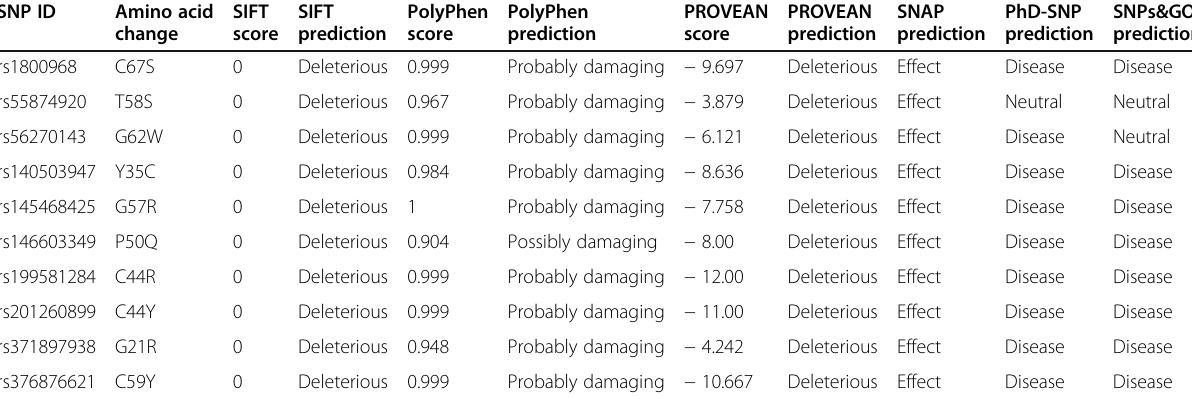
Table 1 List of nsSNPs of the DEFB1 gene predicted as deleterious by different bioinformatics